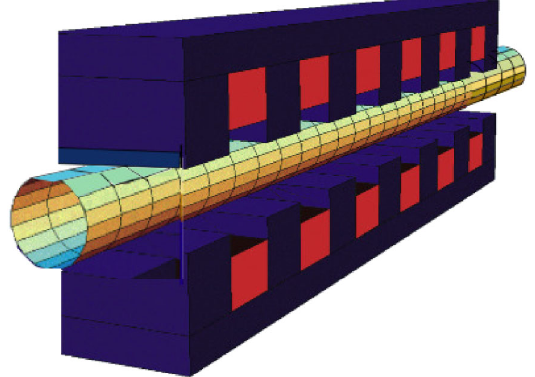
FIG. 1. (Color) A circular cylinder of radius R , centered on the z axis, fitting within the bore of a beam-line element, in this case a wiggler, and extending beyond the fringe-field regions at the ends of the beam-line element.